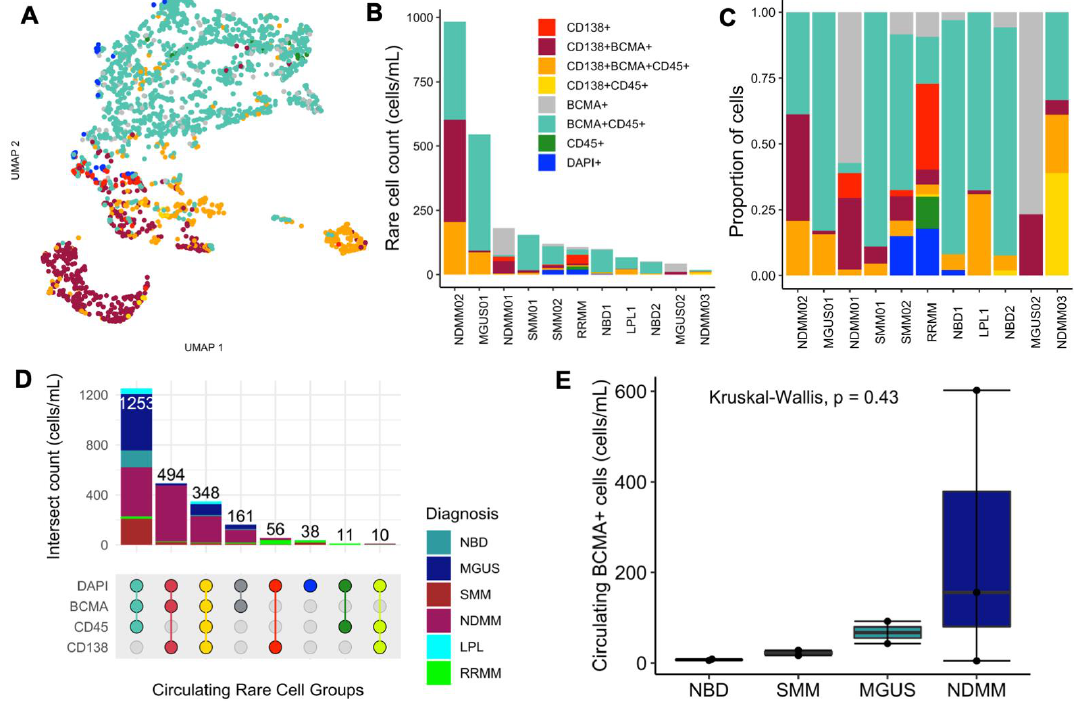
Figure 3. Quantitative enumeration of circulating rare and BCMA+ cells: ( A ) UMAP projection, col- ored by manual cell classification of rare cell groups. ( B ) The total cell count per immunofluores- cence intensity classification. ( C ) Proportions of cells across patients. ( D ) Enumeration by channel type. The color codes in panels ( C , D ) are the same channel-type color codes in the legend shown in panel ( B ). ( E ) Total counts of BCMA+ cells across disease states. The boxplot colors are as shown in the diagnosis color scheme in panel D. Together, the morphological analysis and enumeration in the assay shows that BCMA expression in circulating rare cells is found across different cell sizes and with var- ying CD138 and CD45 patterns, with higher counts in NDMM compared to other condi- tions. 2.4. scCNV for BCMA-Expressing Cells and Correlation with FISH Cytogenetics BCMA expression has been shown to be higher in malignant PCs than in normal PCs and is progressively expressed from post-GC B cells towards fully differentiated PCs [13]. To investigate whether circulating BCMA+ precursor B cells harbor genomic alterations, scCNV analysis of sequenced BCMA+ and BCMA − cells and correlation with FISH cyto- genetic data were performed to validate the BCMA assay. Candidate circulating rare cells of interest from seven patients and two NDs were sequenced. No cells were picked and sequenced from the MGUS2 and LPL patients. Representative scCNV profiles and the re- spective marker expression and morphology of the sequenced single cells are shown in Figure 4A. Of all sequenced cells ( N = 108), 50 and 58 displayed altered and non-altered CNV profiles, respectively. Quantitative cell counts for both normal and altered scCNV across patients (Figure 4B) and across disease states (Figure 4C) showed that altered cells were identified in all disease states and across 6/7 patients (the four sequenced cells in SMM2 had normal scCNV profiles). For controls, all cells from ND samples were normal